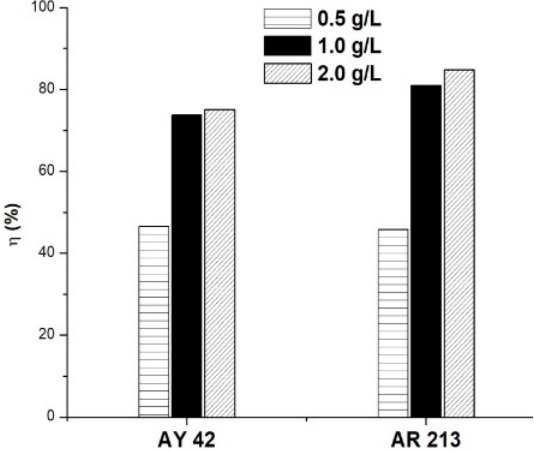
Figure 9. Effect of adsorbent amount on dye removal efficiency using PM4; initial dye concentration 50 mg/L, 25 °C, natural pH of solution.